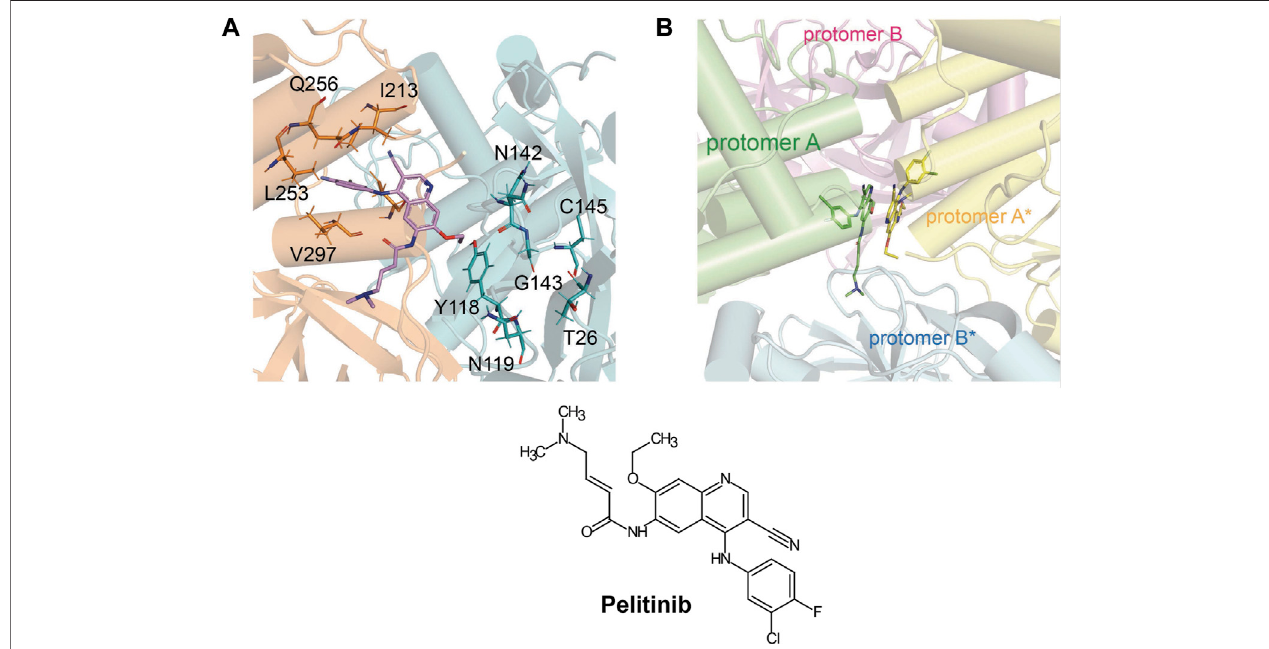
FIGURE14| Close-upviewoftheinteractionsbetweenSARS-CoV-2Mprowithpelitinib.Close-upviewofinteractionbetweenSARS-CoV-2Mproandinhibitorsin crystal structures. Mpro is shown as cartoon representation, with residues involved in the interaction shown as sticks. Inhibitors are shown as sticks. Hydrogen bonds were labeled with dashed lines. (A) Binding site of pelitinib (PDB: 7AXM), violet, in the Mpro dimer, orange and teal. (B) Crystal packing of pelitinib, green and yellow sticks. One Mpro dimer is shown in green and magenta. A second dimer (*) is shown in yellow and light